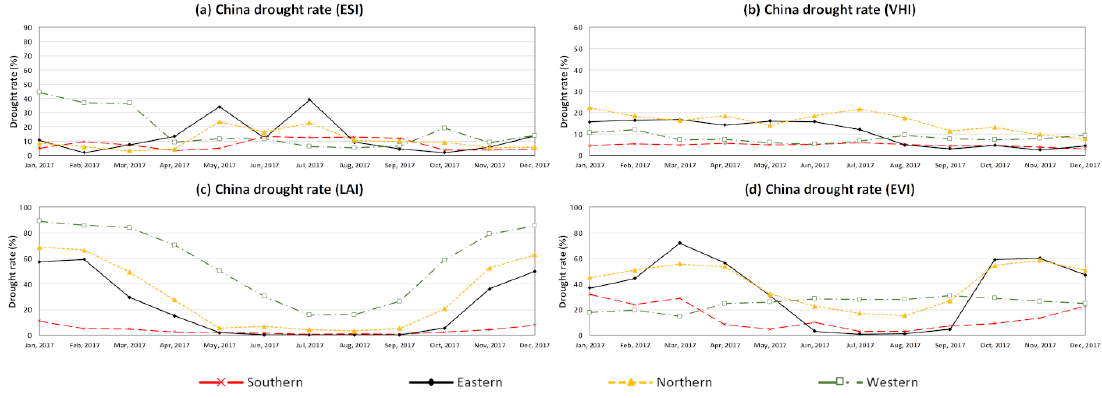
Figure 7. Temporal changes in drought area ratios of total area in each district as determined by the